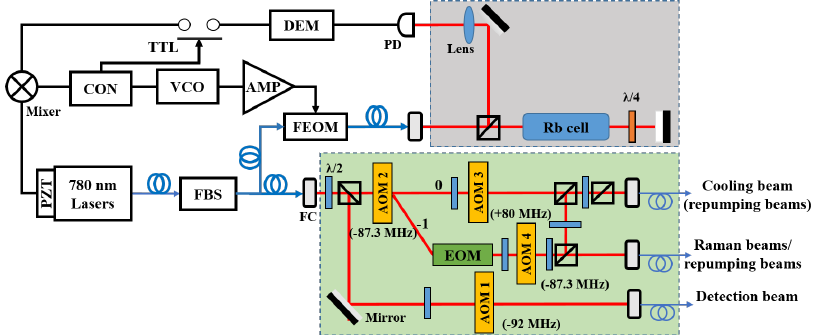
Figure 5. The improved laser system of an AI. The gray area denotes the frequency modulated spectrum, and the green area represents the main optical path (VCO: voltage-controlled crystal oscillator; FEOM: fiber-coupled electro-optic modulator; FBS: fiber-coupled beam splitter; PZT: piezoelectric transducer; FC: fiber collimator; PBS: polarization beam splitter; λ /2: half-wave plate; λ /4: half-wave plate; PD: photodiode; EOM: electro-optic modulator; Rb Cell: rubidium vapor